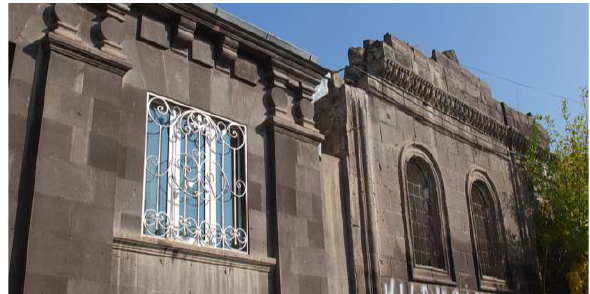
Figure 21. The new and the old black tuff houses on Shiraz Street. Photo by the author,